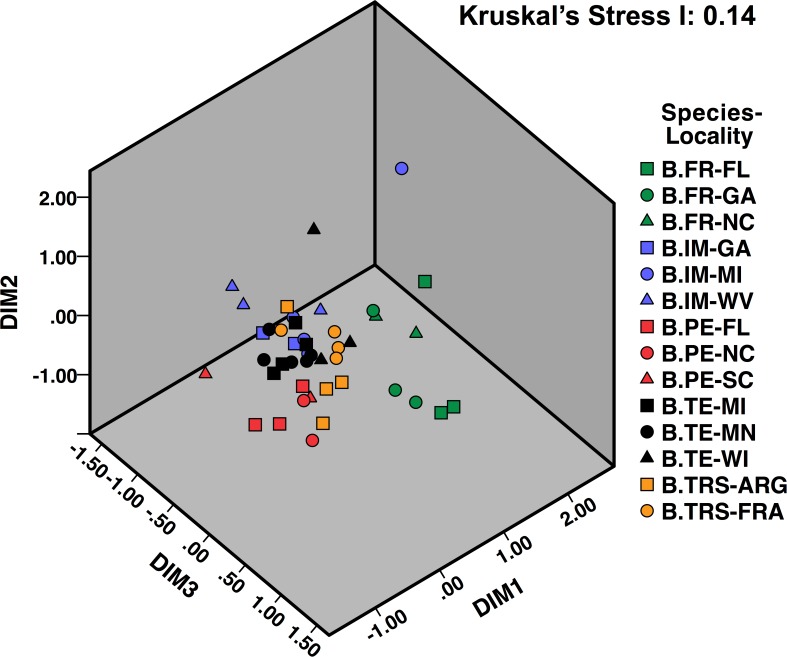
Three-dimensional (DIM1–3) nMDS ordination of ARISA profiles of different bumble bee gut DNA samples.Corresponding bumble bee species and populations (collection sites) are illustrated by the colors and shapes of the markers on the right. Abbreviations: B.FR = B. fraternus; B.IM = B. impatiens; B.PE = B. pensylvanicus; B.TE = B. terricola; B.TRS = B. terrestris. Abbreviations following species names represent different collection sites, sorted by states in the US (FL, GA, MI, MN, NC, SC, WI, and WV), or across countries (ARG and FRA). ARG: Argentina, FRA: France.